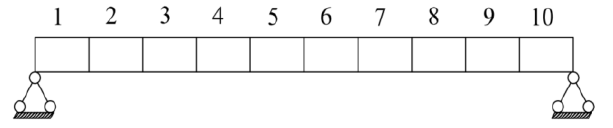
Figure 4. beam-type bridge model. Figure 4. Beam-type bridge